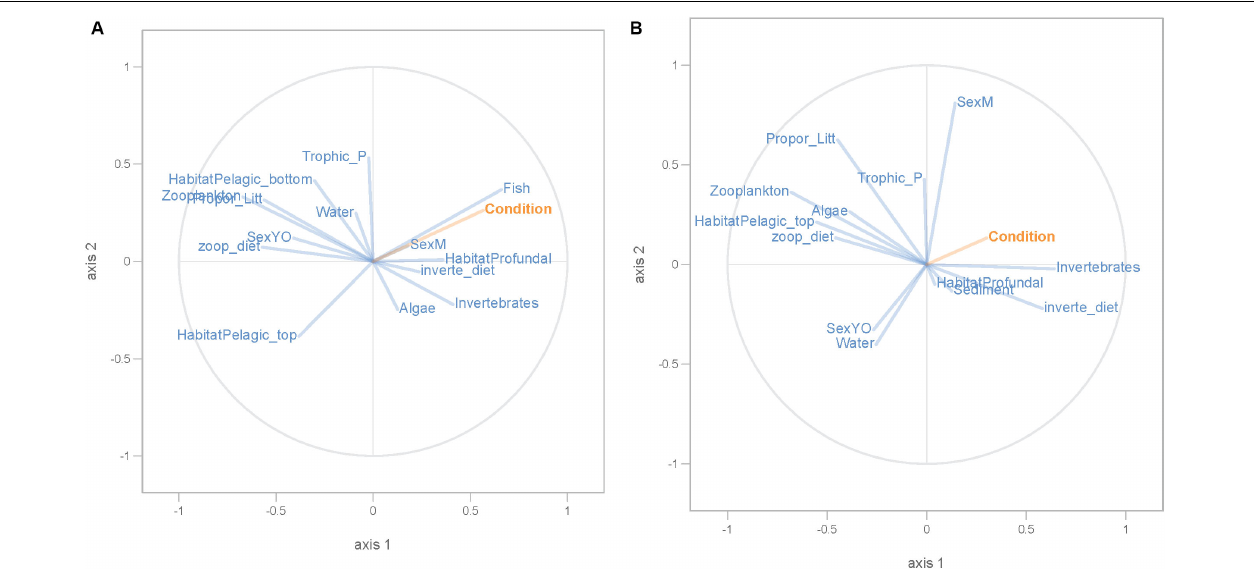
FIGURE 7 | PLS regression analysis between fish body condition and environmental and dispersal factors. Fish body condition was used as response variable (orange lines), whereas dispersal and environmental factors were used as predictor variables (blue lines) in perch (A) and roach (B) .